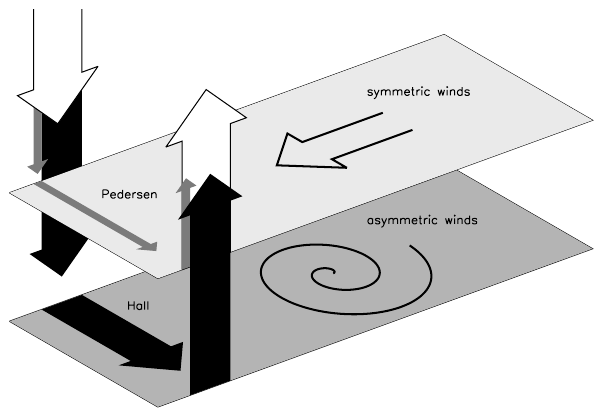
Fig. 3. Schematic of ionospheric current systems for an asymme- try in the Hall region. Axisymmetric neutral winds in the Pedersen conducting layer – expected to be primarily subcorotational – are associated with the Hill current system that transfers angular mo- mentum to the magnetosphere (grey arrrows). However, if the Hall conductivity is significant, then asymmetric winds in this layer – which need not be subcorotational – may also drive currents into the magnetosphere (black arrows). If these currents are greater than the Hill currents, they may dominate the total current (white arrows) and thus dominate the perturbation to the magnetospheric